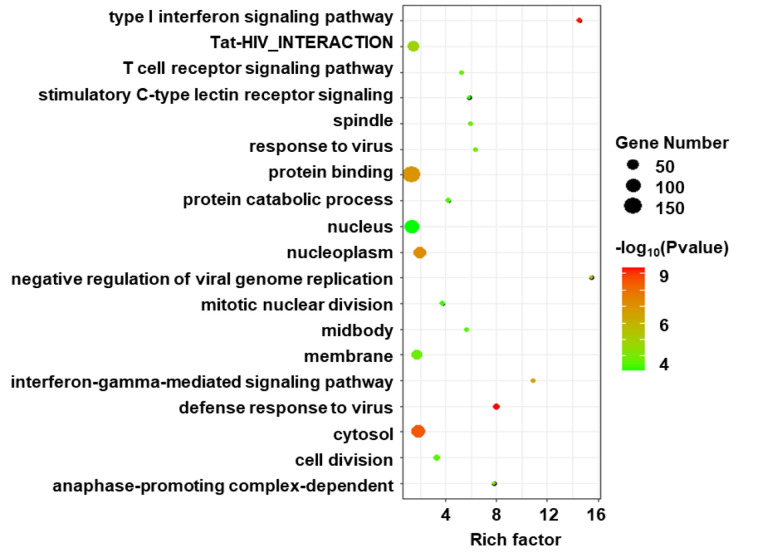
Gene ontology (GO) enrichment analysis of DEGs in HIV positive patients with TB compared with TB negative. The size of circle indicates the gene number; the color presents the log P-values. p < 0.05 and FDR < 0.01 were used as the threshold for pathway assignment. Note that the most DEGs were enriched in virus related pathway such as “defense response to virus” and “Type I interferon signaling”.